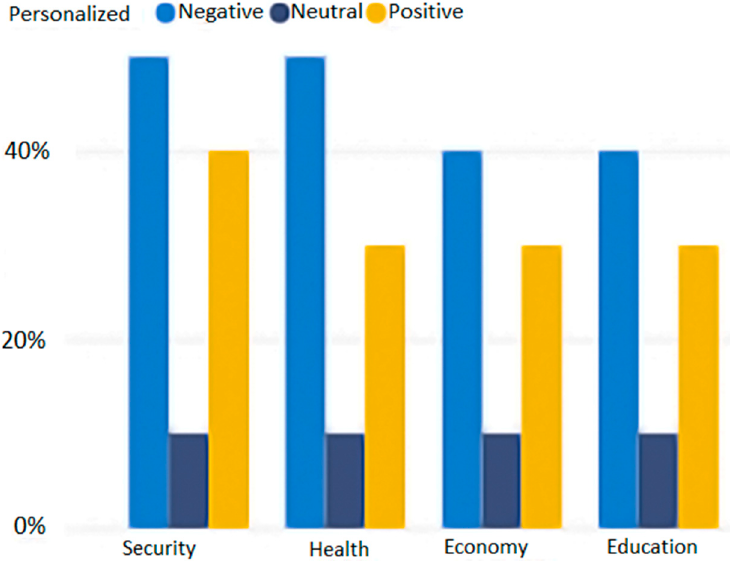
Figure 5. Identification of feelings in the search categories in relation to the government of Ecuador.